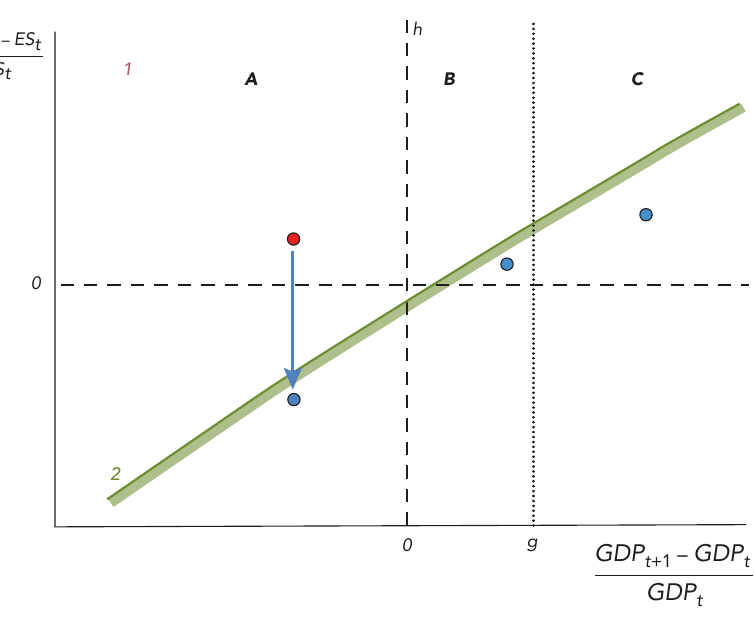
Figure 3. Degrowth strategy fails in case of no conflict between growth and environmental sustainability, while agrowth and growth strategies remain within feasibility area indicated by area below green curve